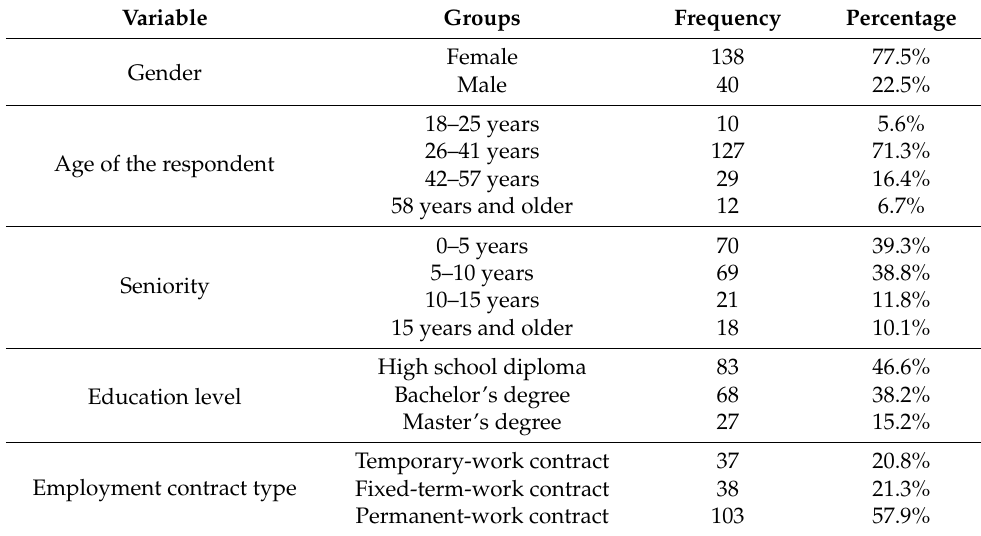
Table 1. Descriptive statistics of sample demographic